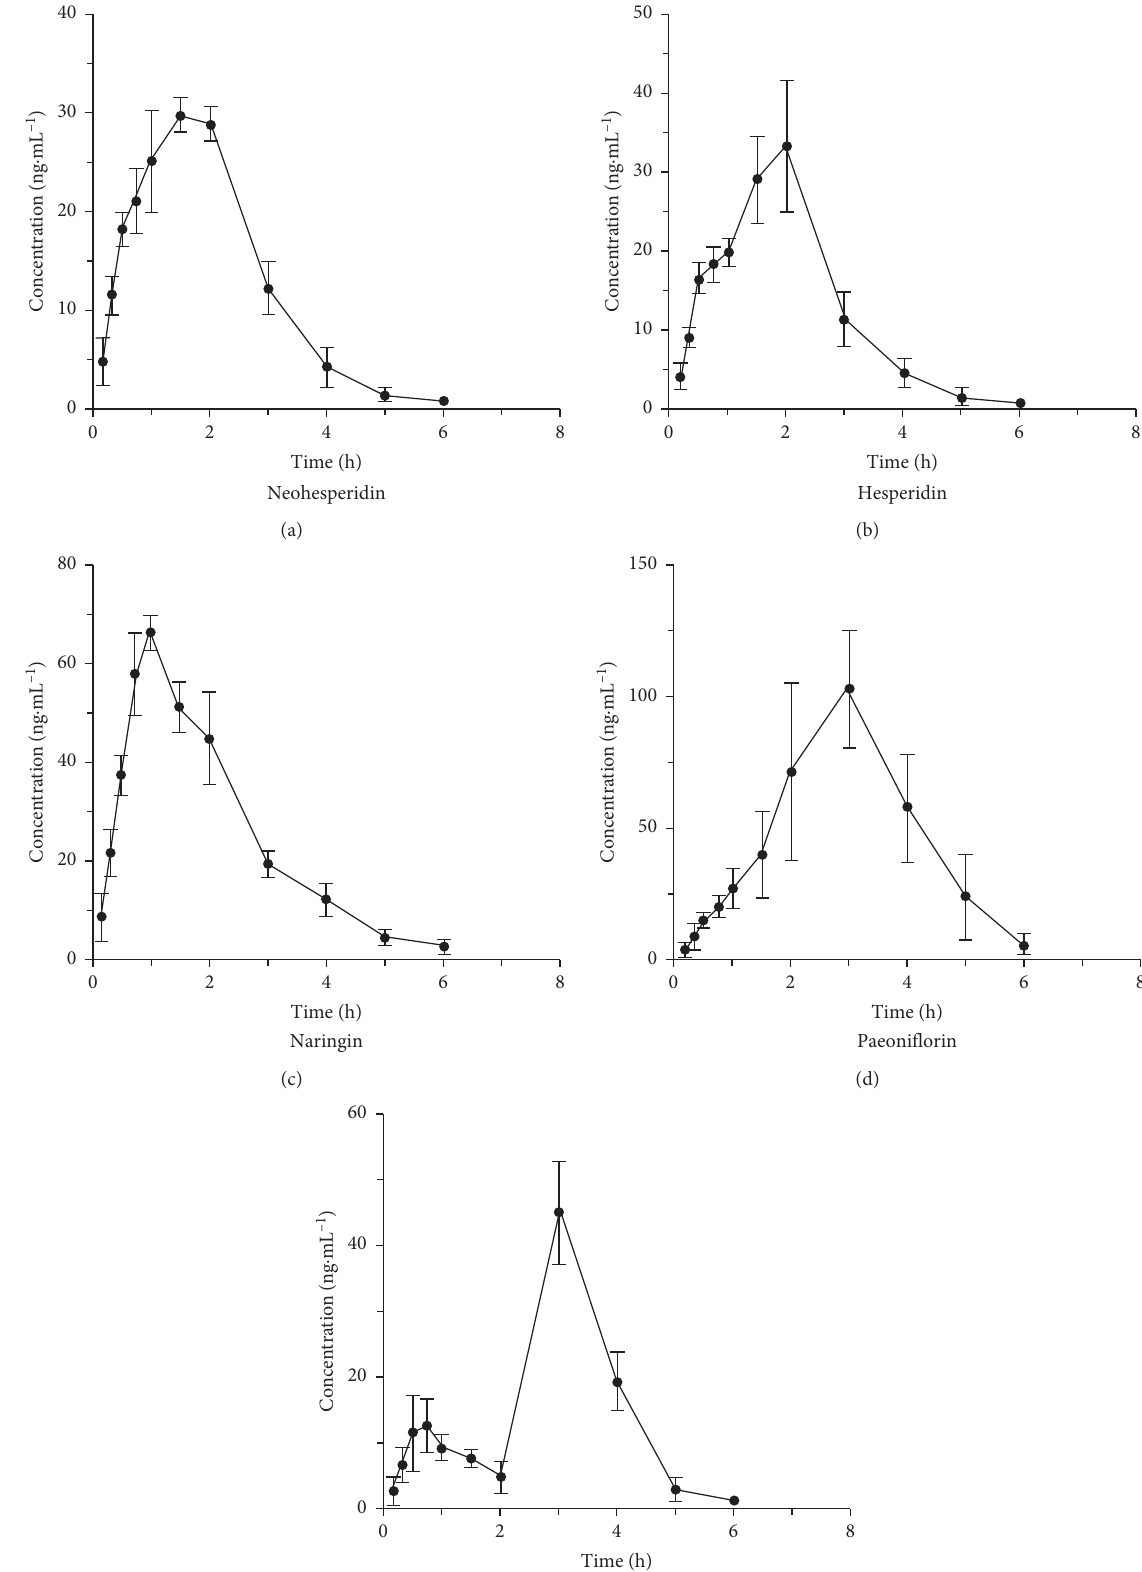
Figure 3: Mean plasma concentration: time curves of five analytes after a single dose of CHSGS ( n �